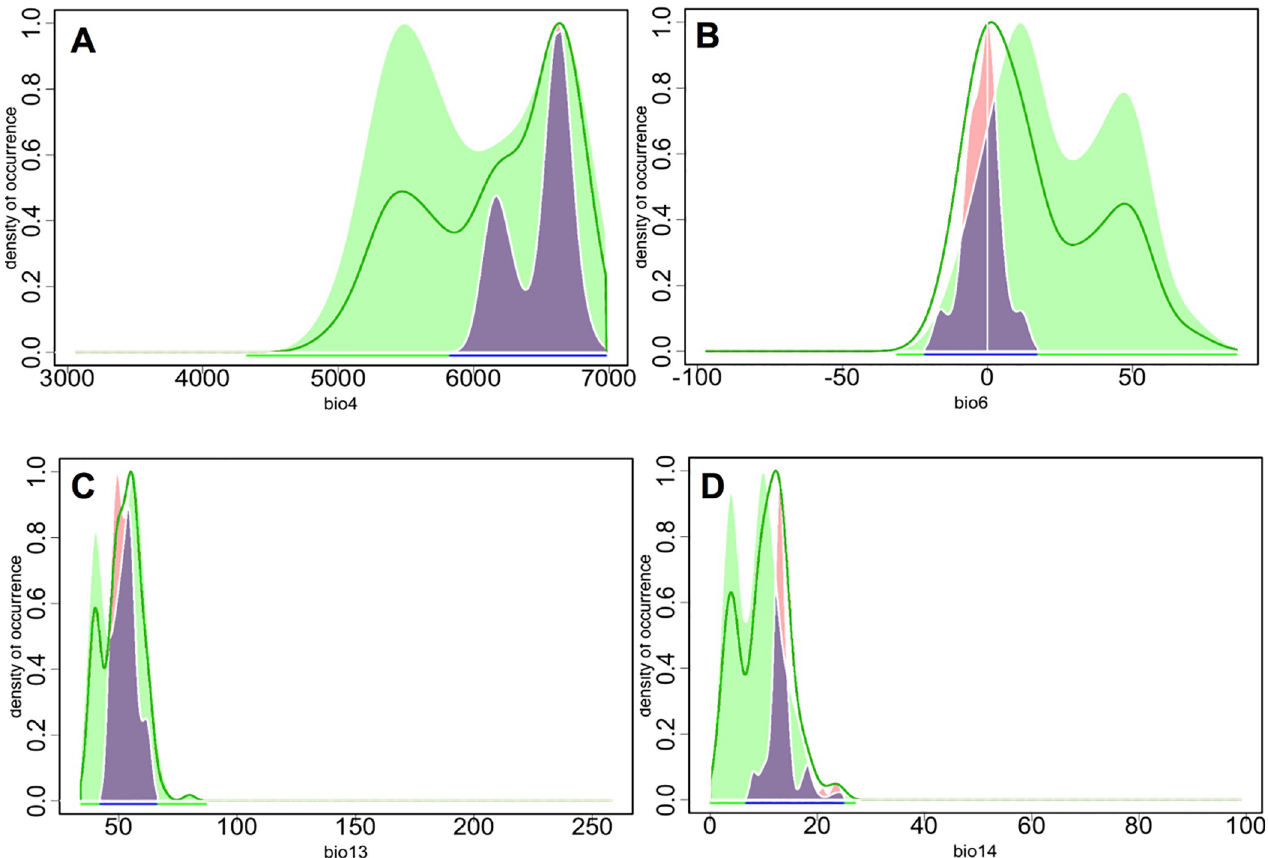
Fig 7. Occurrence density curves for specific bioclimatic variables of G . bermejoi (pink) and G . struthium subsp. struthium (green). The pale violet areas represent overlapping areas under the curves. Again, the narrow bioclimatic niche of G . bermejoi becomes evident.